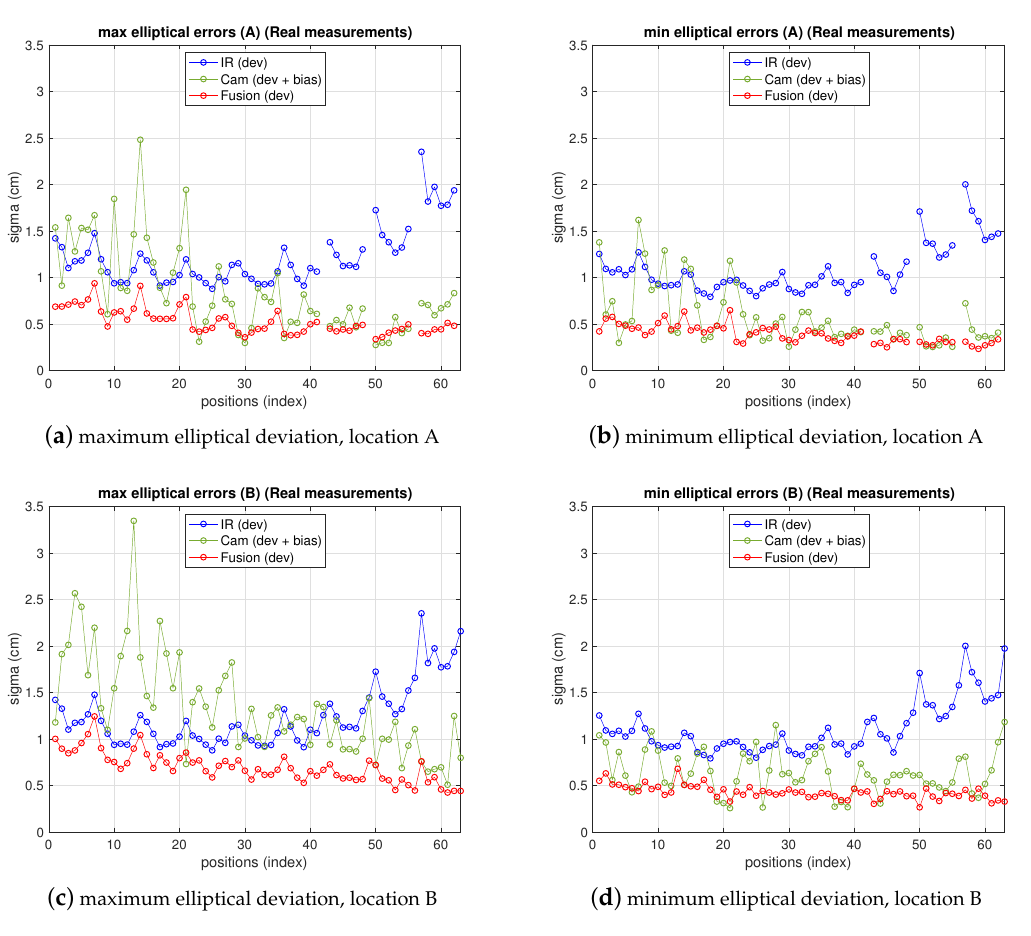
Figure 13. Errors for IR, camera (includes bias) and fusion estimations from real measurements at locations A (top) and B (bottom). Left: maximum elliptical deviation; right: minimum elliptical